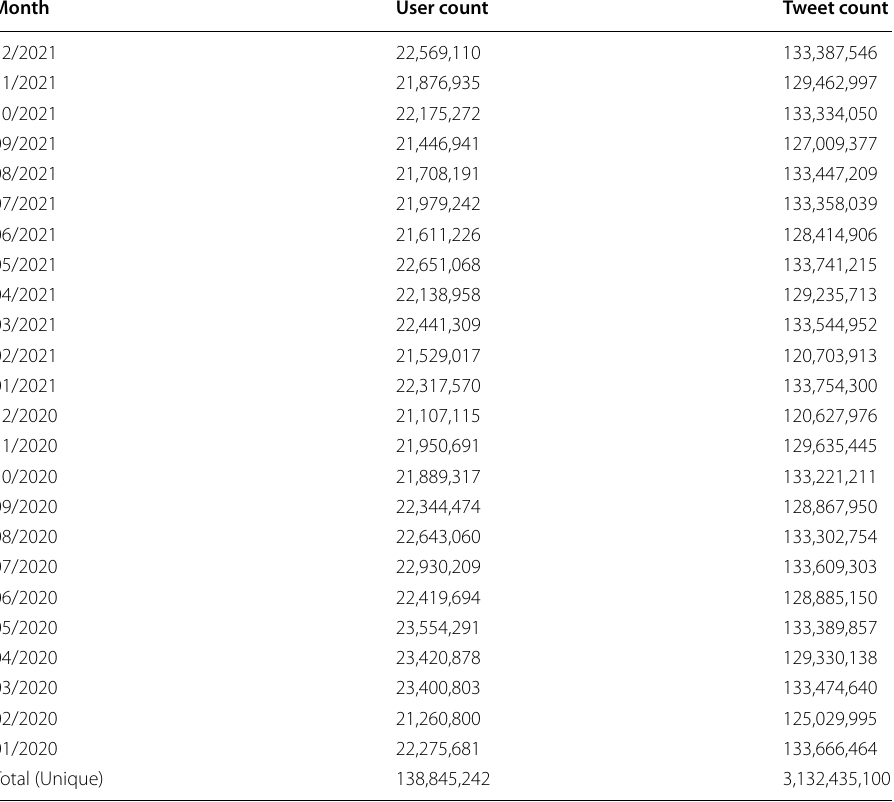
Table 3 Monthly data statistics of the pools of random Twitter users and tweets Month User count Tweet